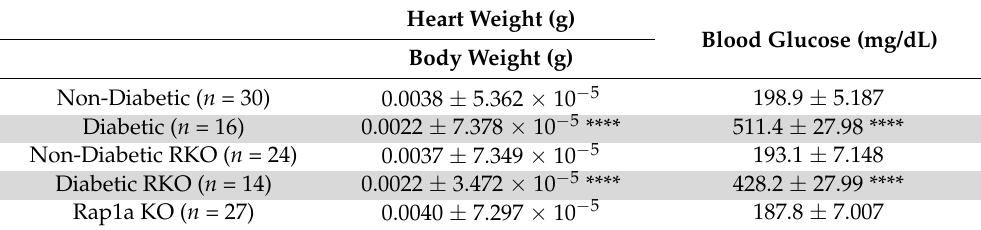
Table 1. Physiology measurements of mice used in this study. Average values for ratio of heart weight/body weight and blood glucose for mice. On average, 2–3 mouse hearts were used for one cardiac fibroblast isolation. Statistical analysis consisted of one-way ANOVA followed by a Dunnett’s post hoc compared to non-diabetic mice (**** p < 0.0001). Heart Weight (g) Blood Glucose (mg/dL) Body Weight (g) Non-Diabetic ( n =